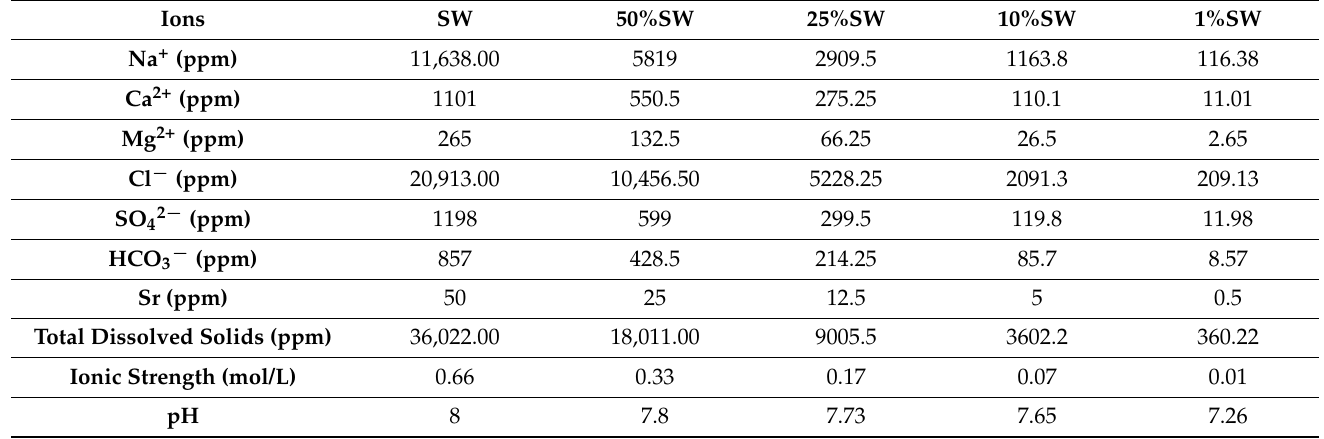
Table 1. Ionic concentrations, TDS, pH, and Ionic strength of diluted brines.